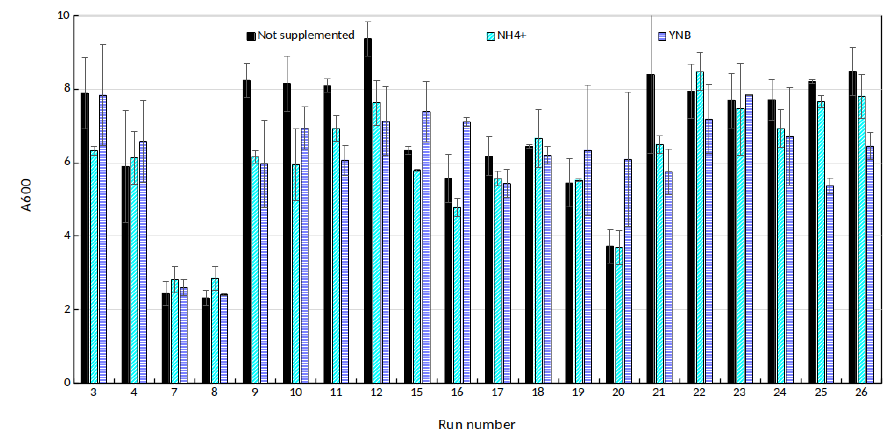
Figure A1. Final optical density for the different media with and without nitrogen